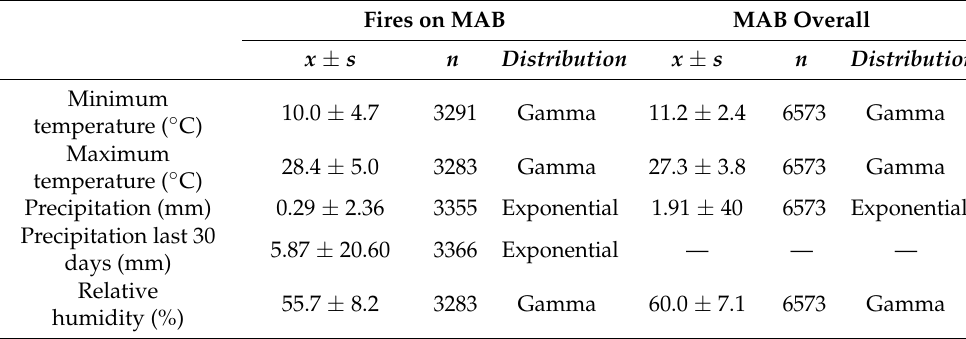
Table 1. Atmospheric variables in MAB and subset of days with fires. Fires on MAB MAB Overall x ± s n Distribution x ± s n Distribution